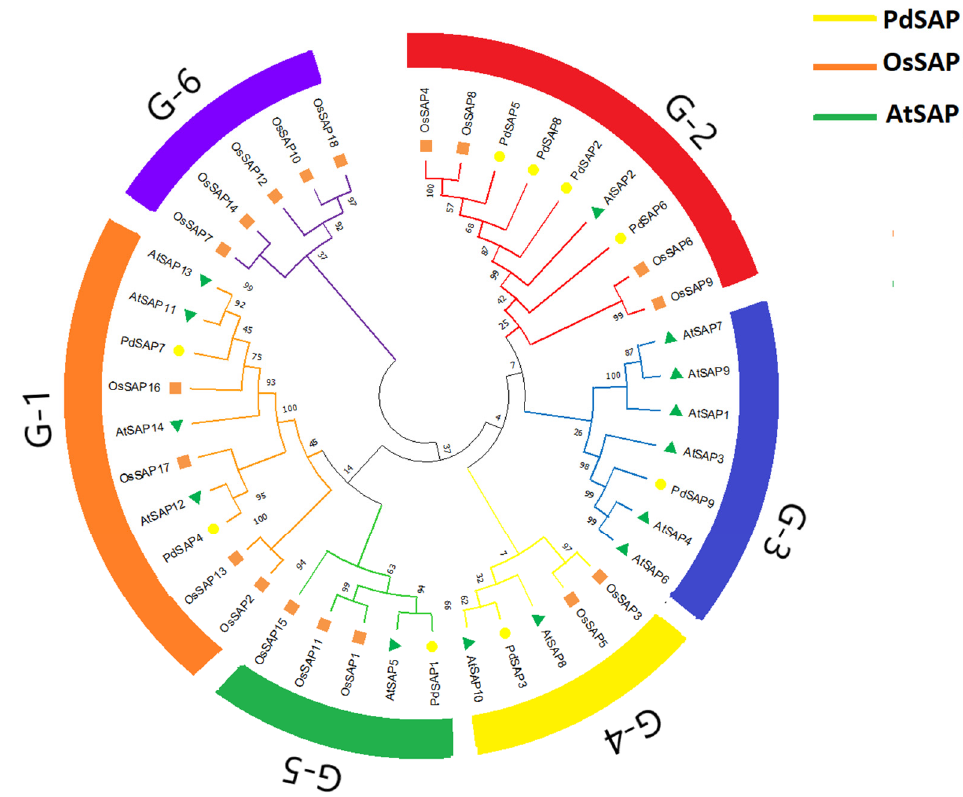
Figure 2. Phylogenetic tree of PdSAP genes with A. thaliana and O. sativa. PdSAP genes are classified into six subgroups (G1–G6) based on number of SAP genes present in groups. The six subgroups are marked in different colors.